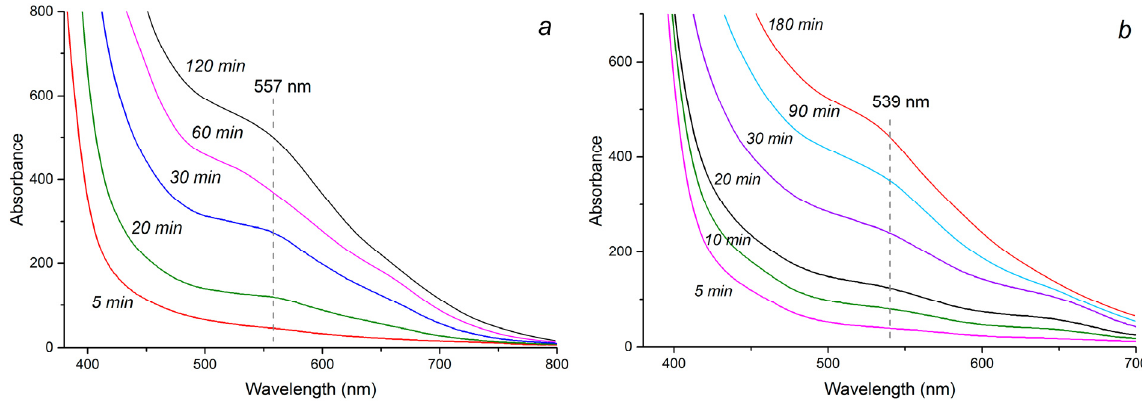
Figure 4. UV spectra of aqueous solutions of polymer nanocomposites 2 ( a ) and 4 ( b ). Electronic absorption spectra of nanocomposites 1 – 4 were recorded after adding copper acetate monohydrate to a mixture of polymer and ascorbic acid at different times.